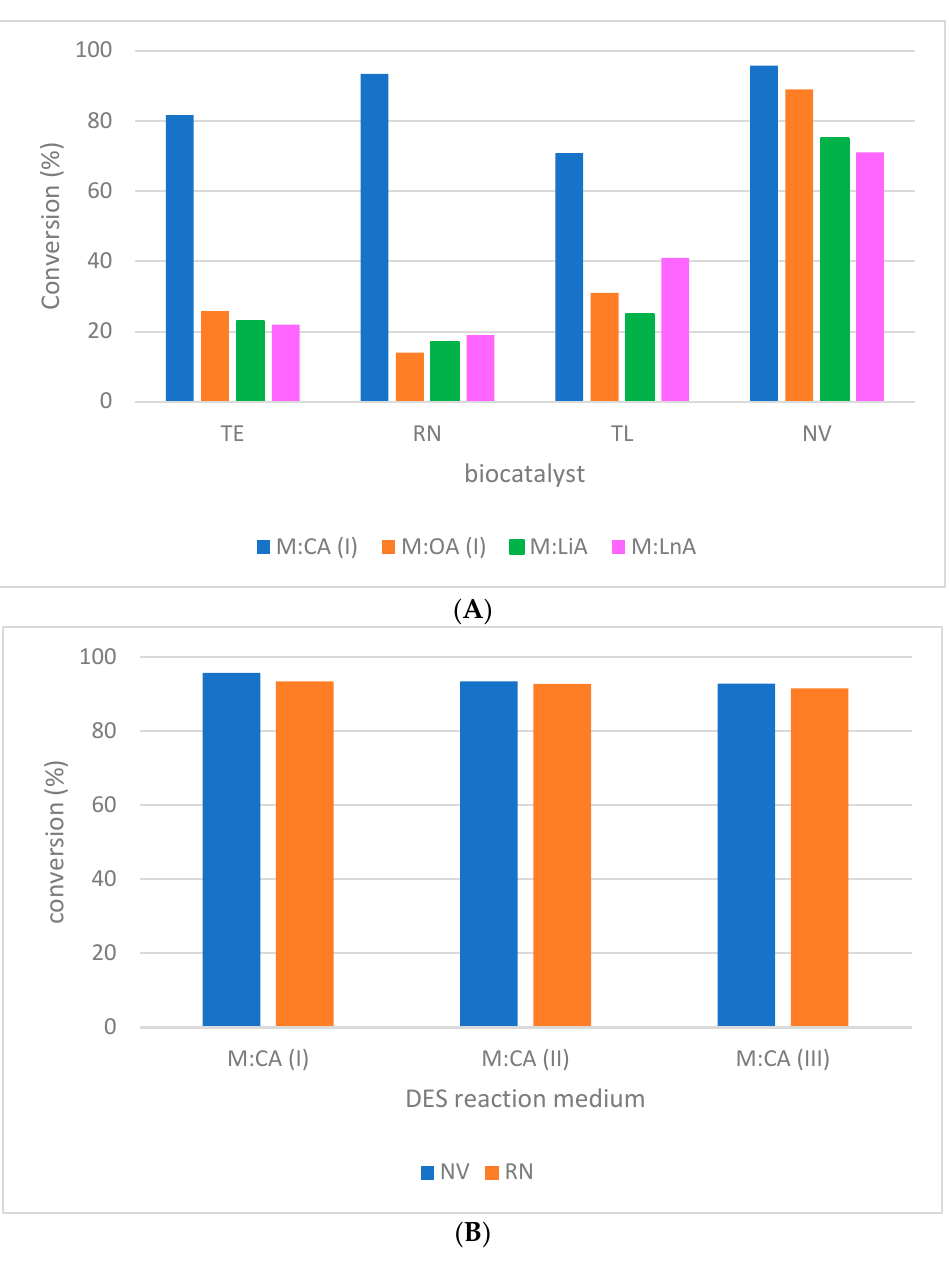
Figure 2. Evaluation of the performance of the biocatalytic system for different DES compositions (( A )—different H donor of DES and ( B )—different concentration of the H donor in DES). Experi- mental conditions: 1.58 mM MLE, L -menthol:MLE = 3:1 molar ratio, 1 mg/mL lipase biocatalyst in DES reaction medium, 40 °C temperature, 1000 rpm shaking, and 24 h reaction time. Triplicate measurements of the samples with maximum 25% RSD.